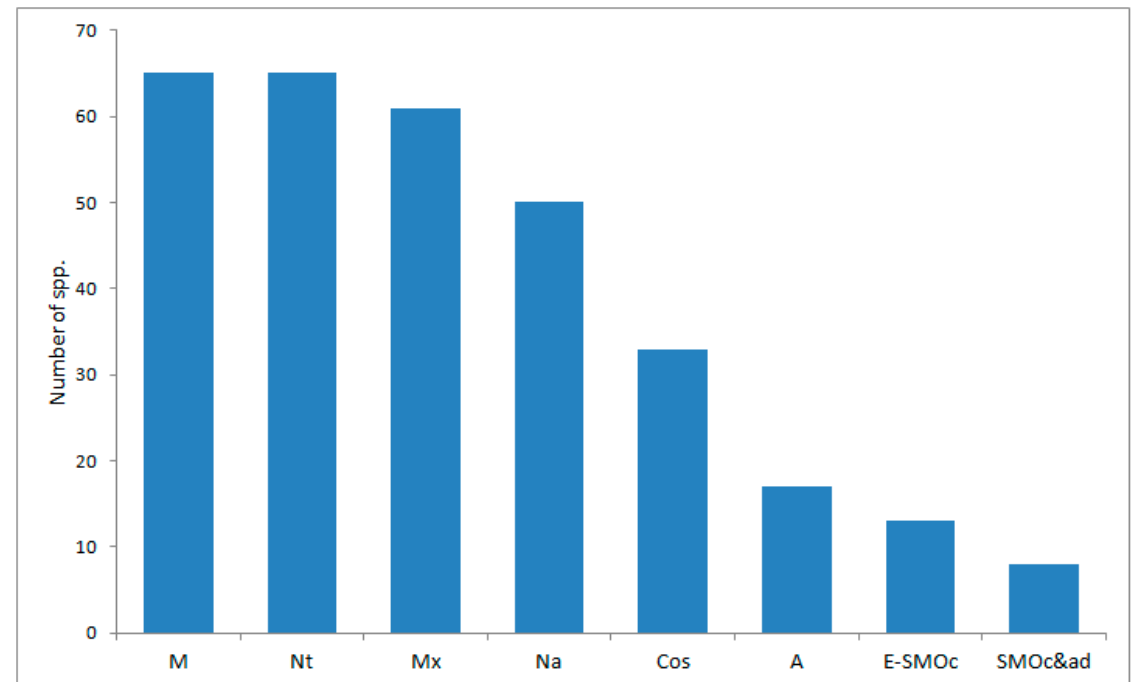
Figure 5. Geographic distribution of the pteridoflora of the SMOc. The abbreviations are: (Cos) Cosmopolitan; (A) American; (Na) Nearctic; (Nt) Neotropical; (M) Mesoamerican; (Mx) Endemic to Mexico; (E-SMOc) Endemic to the SMOc; (SMOc&ad) Regional endemic to northwestern Mexico.